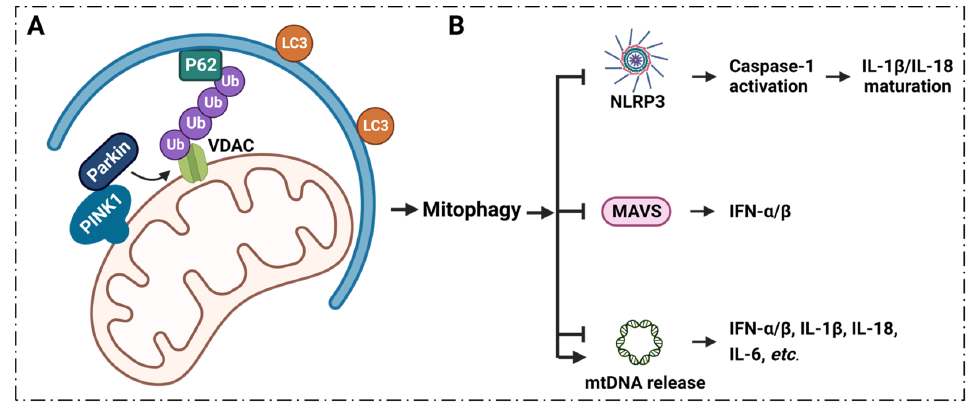
Figure 4. VDAC1, PINK1/Parkin signaling and mitophagy. ( A ) PINK1/Parkin targets damaged mitochondria, ubiquitinates VDAC1, and ultimately degrades damaged mitochondria by promoting mitophagy. ( B ) Mitophagy modulates NLRP3, MAVS and mtDNA release, affecting the immune response. NLRP3 activates caspase-1 to promote IL-1 β /IL-18 maturation. MAVS enhance IFN- α / β expression. Meanwhile, mitophagy suppresses NLRP3, MAVS and mtDNA release, which results in reduced cytokines release. Additionally, mitophagy can also promote mtDNA release, which affects cytokines expression. Abbreviations: IL: interleukin; IFN: interferon; LC3: microtubule-associated proteins 1A/1B light chain 3; MAVS: mitochondrial antiviral signaling protein; NLRP3: nucleotide- binding domain and leucine-rich repeat (LRR) containing P3; PINK1: PTEN-induced putative kinase 1;; Ub: ubiquitin; VDAC1: voltage-dependent anion channel The PTEN-induced putative kinase 1 (PINK1) and the RING family ubiquitin ligase Parkin were found to be involved in mitophagy [191–194]. This indicates that induced mitophagy can be accomplished in cells that overexpress Parkin or overexpress PINK1. PINK1/Parkin acts as key regulator of mitophagy, and is vital in controlling infection and the inflammatory response [195]. The interaction of two Parkin domains, RING1 and ubiq- uitin-like (UBL), affects its activity. UBL binding with RING1 results in the inactive state of Parkin; PINK1 phosphorylates UBL-Ser65, leading to the activation of Parkin to pro- mote substrate ubiquitination, with VDAC1 included [196].